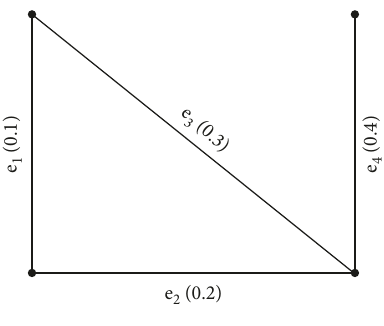
Figure 1: The fuzzy graph ( V, μ )